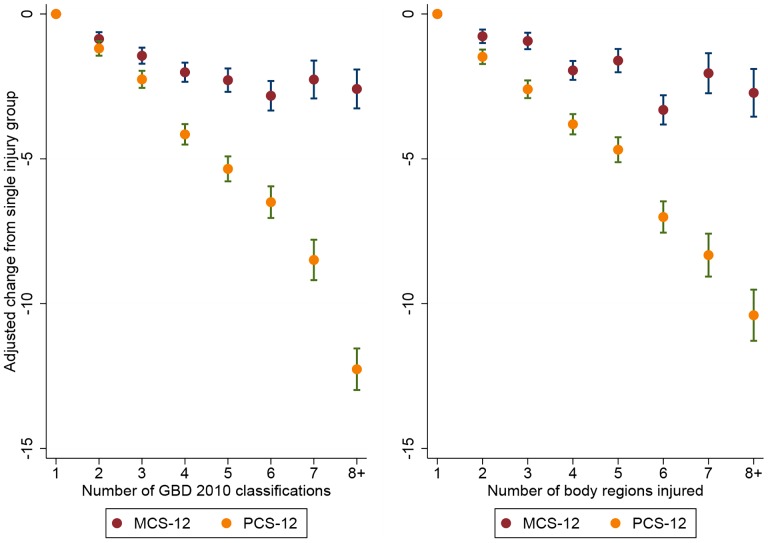
Adjusted difference in mean MCS-12 and PCS-12 scores by number of injuries sustained (adjusted for age, gender and data source (study)).